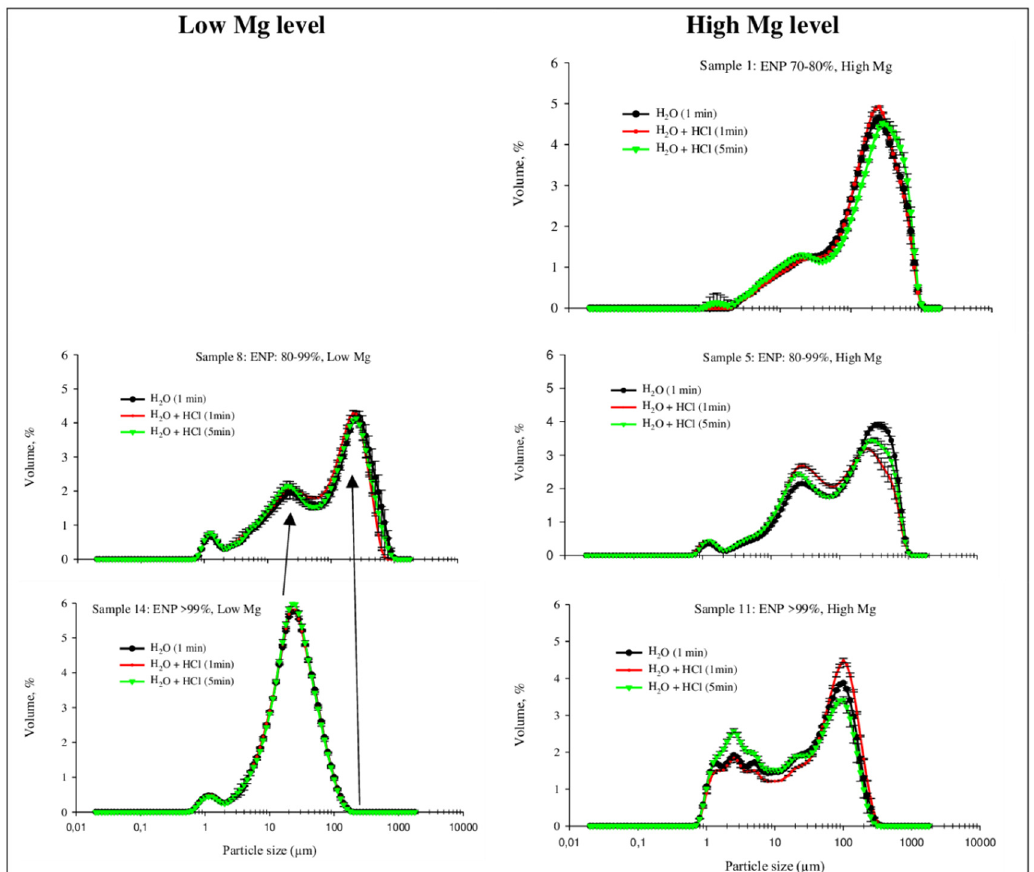
Figure 3. Diffraction laser granulometric profiles from representative lime/corrective samples were separated into three groups of efficiency neutralizing power (ENP) and two Mg levels (low and high). Limestone samples with higher ENP values (>99%), regardless of the MgO content, had higher proportions of finer particles, concentrated at 1 and 20 µ m peak positions (Figure 3). Peaks bigger than 100 µ m are